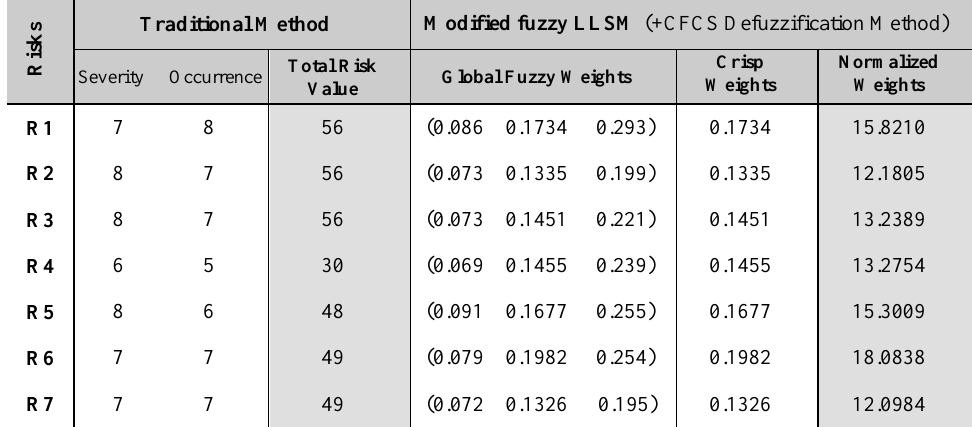
Table 8. Risk values obtained by the traditional method and proposed